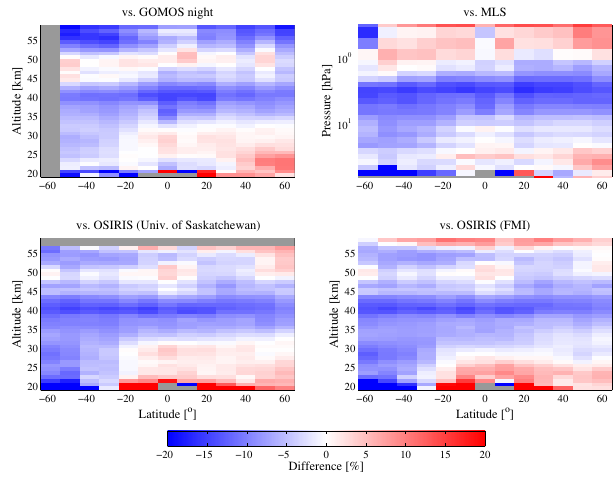
Figure 9. Median relative differences of GBL ozone profiles against GOMOS nighttime occultations (upper left), MLS (upper right), OSIRIS University of Saskatoon version (lower left), and OSIRIS FMI version (lower right).